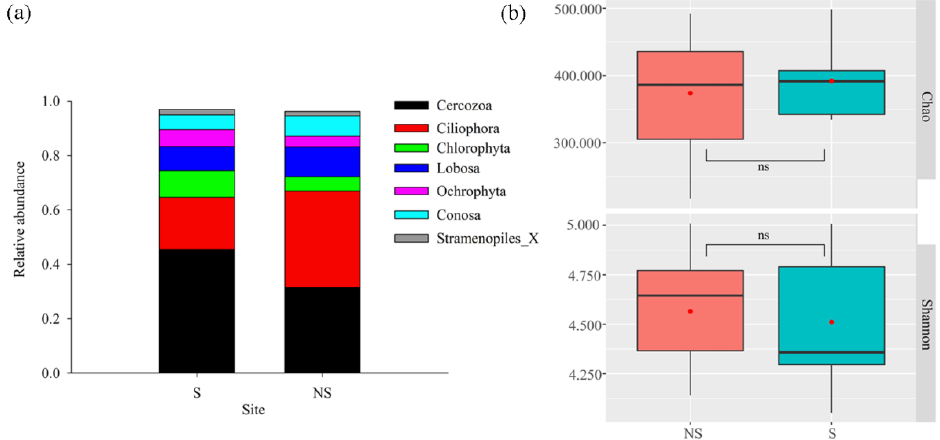
Figure 8. Relative abundances (average values >= 0.01) of dominant phylum composition and alpha diversity of the soil protist communities. ( a ) Dominant phylum of protists; ( b ) comparison of protist diversity indices.